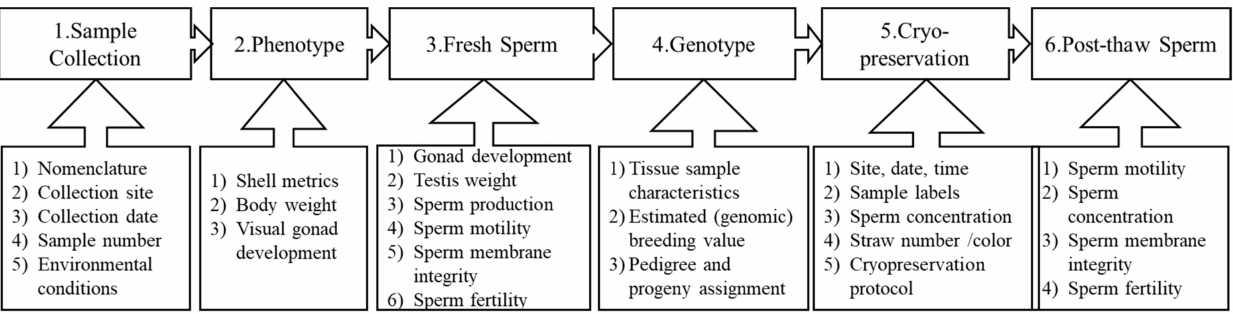
Figure 3. Schematic procedure for Eastern oyster Crassostrea virginica sperm collection and processing for breeding and cryopreservation. Parameters recorded during the process are reported below each individual